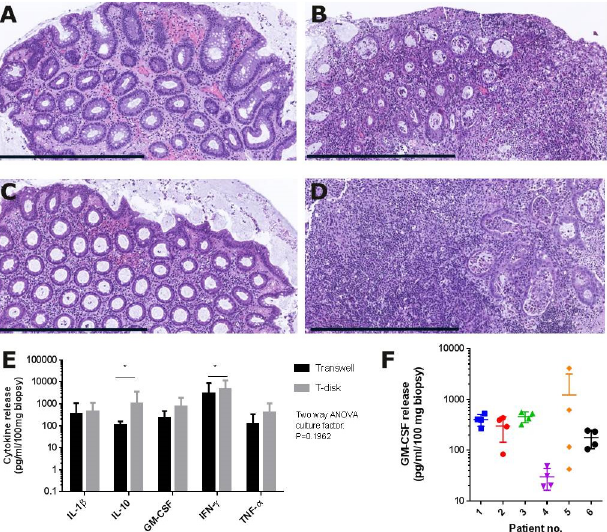
Fig 2. Preservation of tissue morphology and robust cytokine release in the explant assay. Non- inflamed (A, C) and inflamed (B,D) biopsies from the same patient were cultured on T-disks (A, B) or transwells (C,D) for 24 hours and processed for histology. Representative pictures of H&E-stained paraffin- sections (n = 5 patients). Bars = 600 μ m. (E) Spontaneous release of the cytokines IL-1 β , IL-10, GM-CSF, IFN- γ and TNF- α from inflamed biopsies into the culture medium measured by Bio-Plex. Biopsies from the same patients were cultured on either T-disk or transwell as indicated. No difference in cytokine release was observed when comparing T-disk and transwell for all 5 cytokines in combination ( P > 0.05, two-way ANOVA), but when analyzed alone, IL-10 and IFN- γ were significantly increased with T-disk ( * P < 0.05, t- test). 2 biopsies per patient (n = 6). (F) Spontaneous release of GM-CSF from 6 inflamed patients, 4 biopsies per patients taken as closely as possible from each site, all shown individually. Data show mean ±